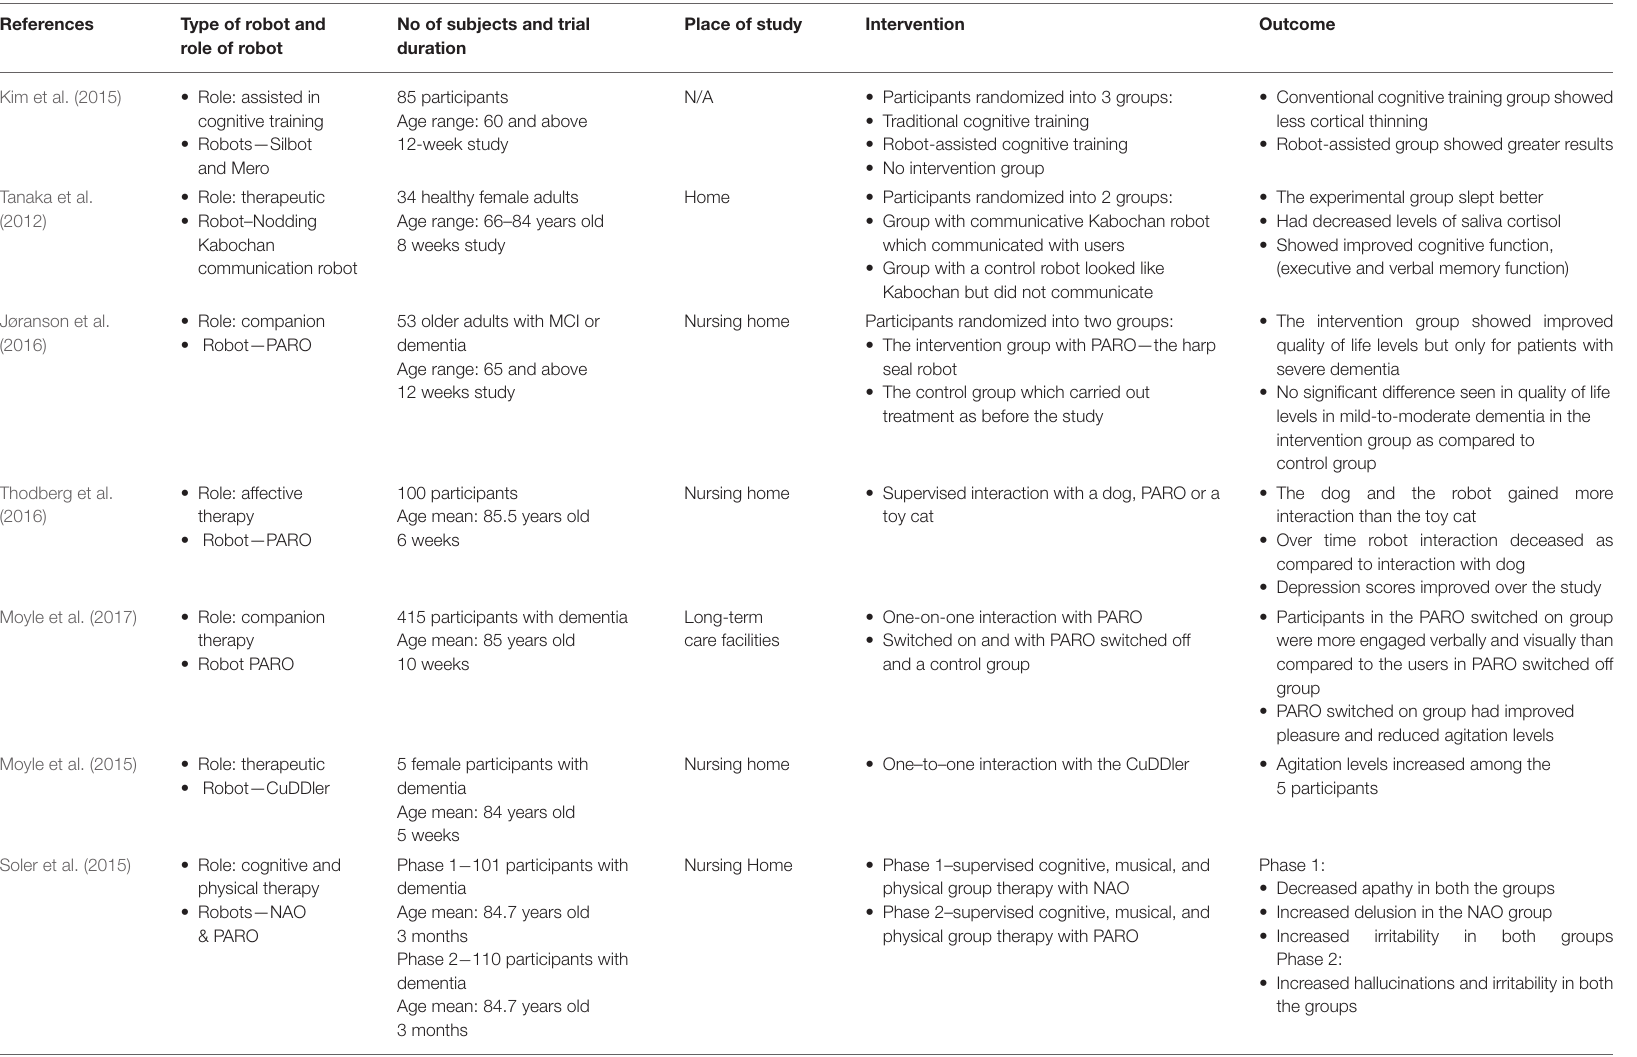
TABLE 4 | Robots used in elderly